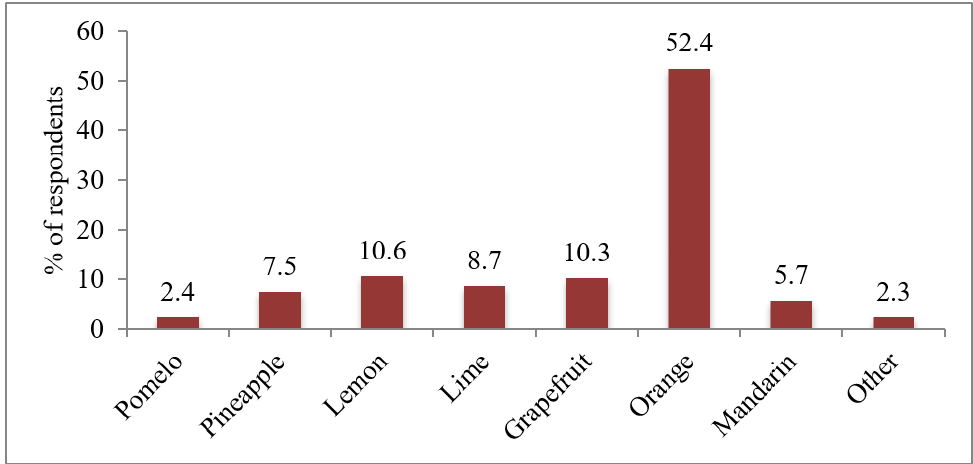
Figure 4. The most popular flavours of citrus fruit